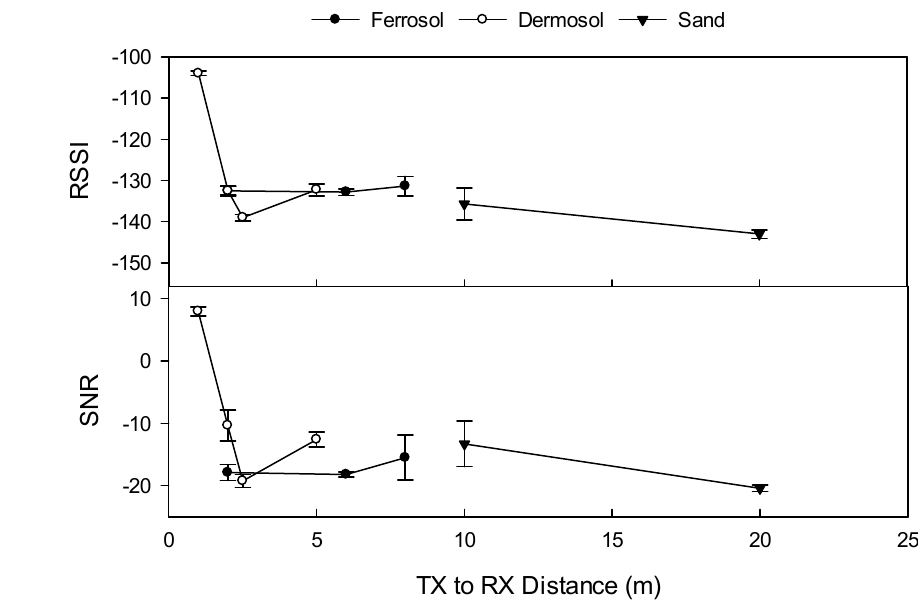
Figure 10. UG2UG transmission distance and quality (0.2 kbps data rate, RX and TX 1/14 λ antenna, +23 dBm TX power, TX and RX depth of 30 cm). RSSI (dBm) refers to received signal strength index, FE (Hz) refers to frequency error, and SNR refers to signal-to-noise ratio. Error bars indicate ±1 standard deviation.